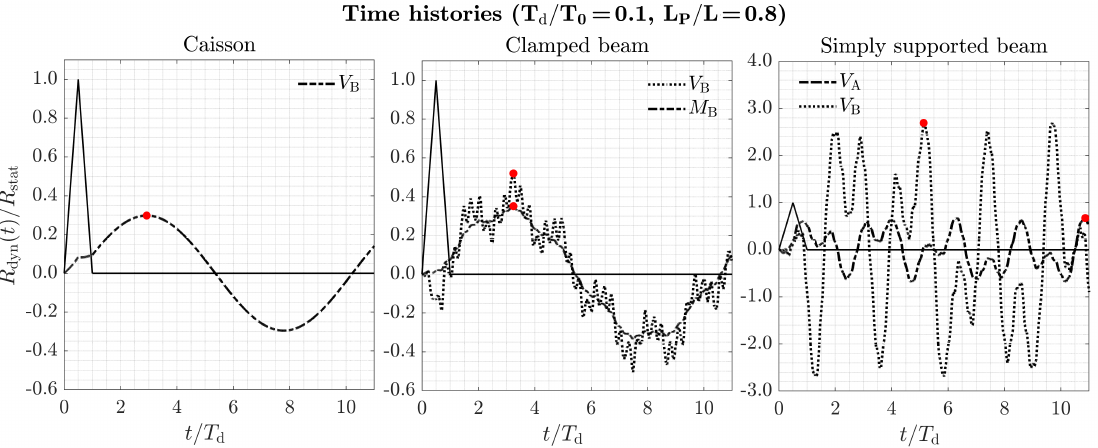
Figure 12. Time-histories of the (normalized) static and dynamic support reactions for caisson structure ( left ), clamped beam ( middle ), and simply supported beam ( right ) subjected to the same a church-roof wave load with moment-arm L P / L = 0.8 and impact duration T d / T 0 = 0.1. Red dots identify the maximum value of dynamic support reaction in time. Total simulated duration is equal to T d + T 0